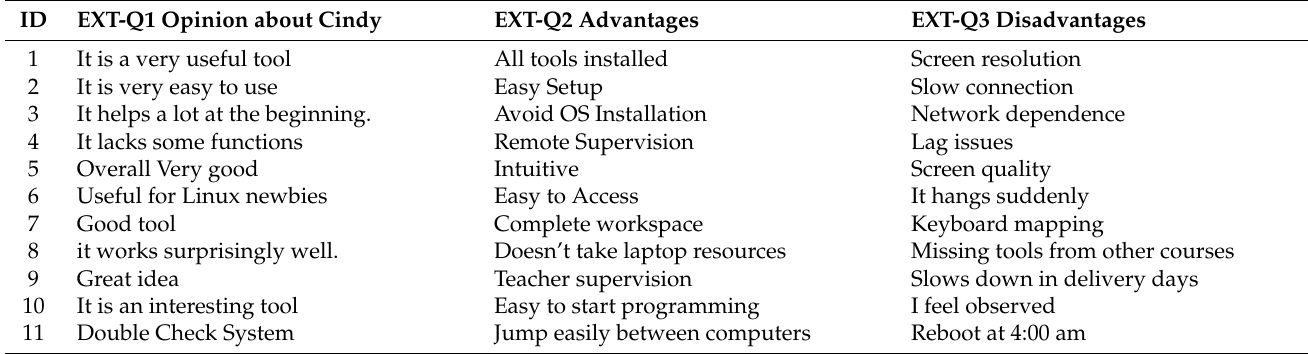
Table 7. Students answers to qualitative